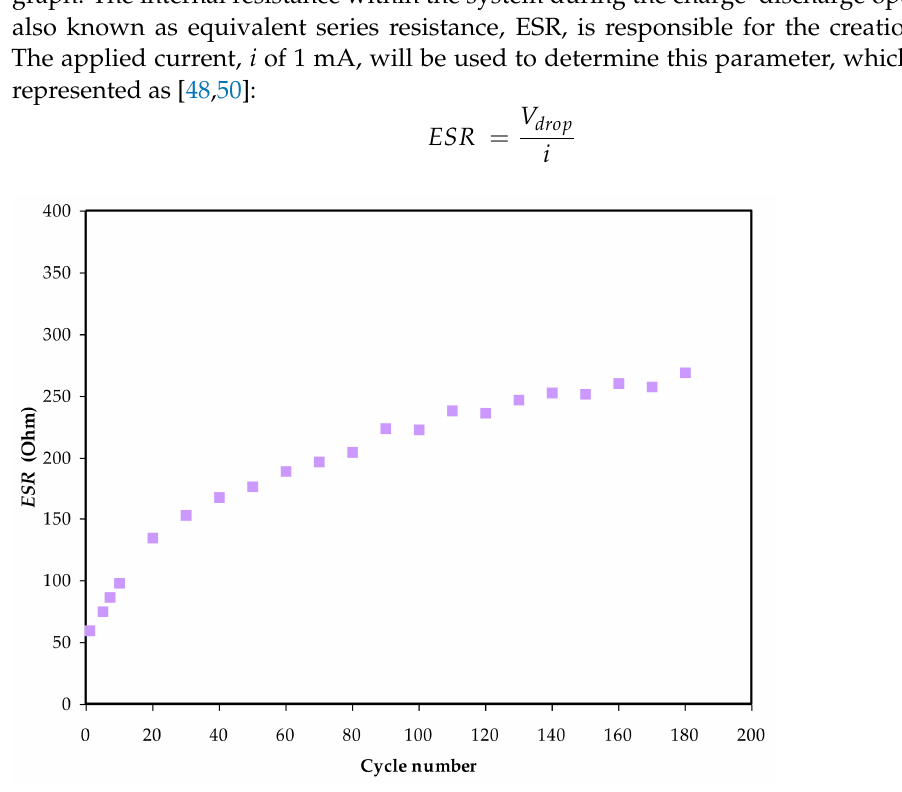
Figure 10. The ESR values versus cycle number of the EDLC